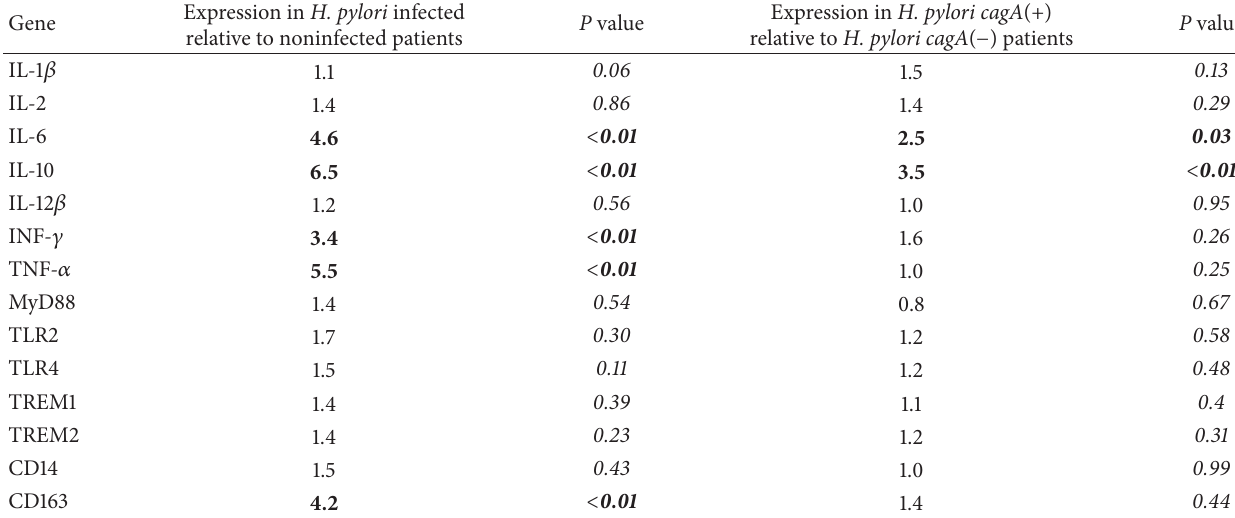
Table 1: mRNA expression of inflammatory mediators in the gastric mucosa in relation to H. pylori and cagA status. Gene